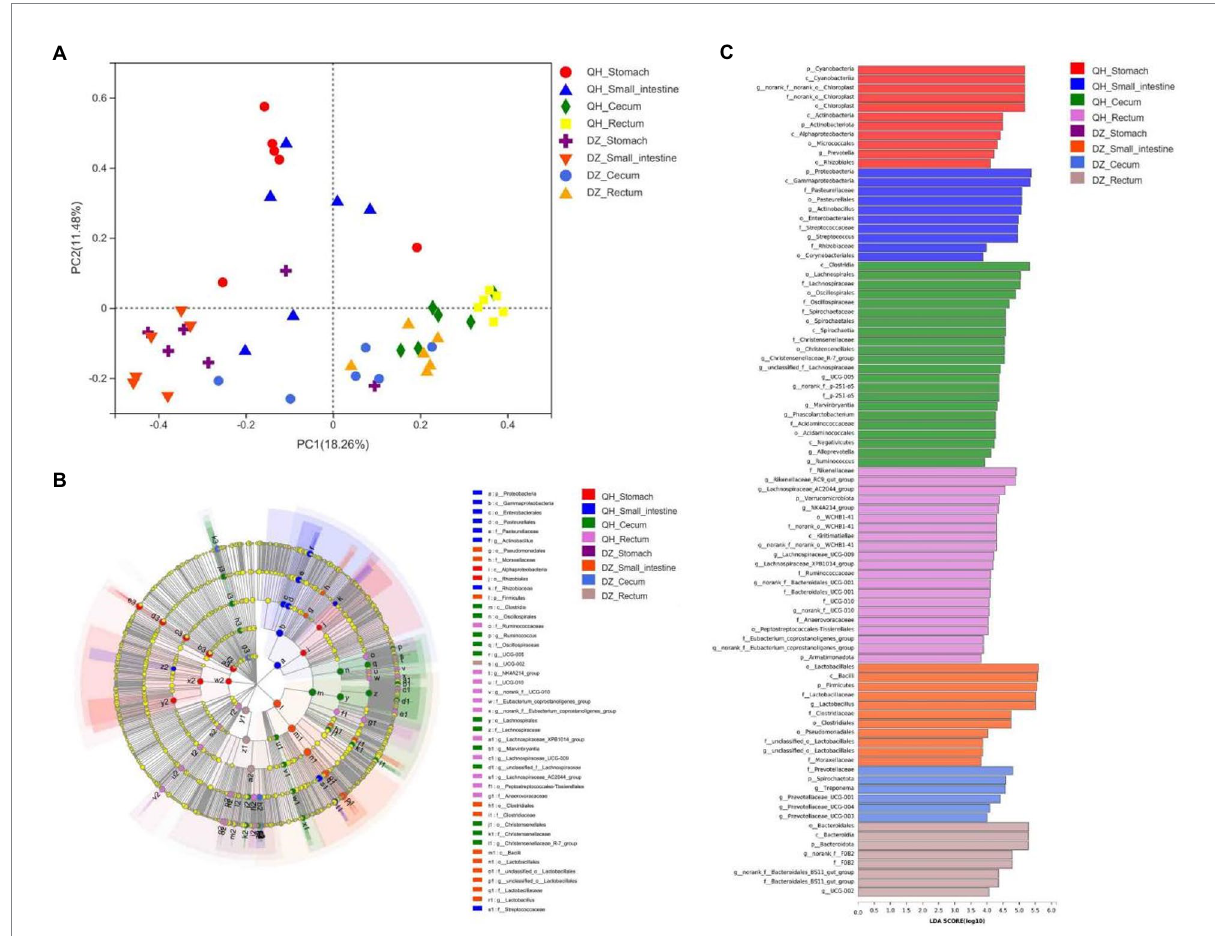
FIGURE 3 Beta diversity analysis. (A) PCoA picture. The X -axis and Y -axis represented the two selected primary axes, and the percentages represented the explanatory value of the differences in sample composition by the primary axes; points with different colors or shapes represented samples in different groups: the closer the two sample points, the more similar the species composition of the two samples. (B) LEfSe diagram. Nodes with different colors indicate microbial groups that were significantly enriched in the corresponding groups and have a significant impact on the differences between groups; light yellow nodes indicate microorganisms that have no significant differences in different groups or have no significant impact on differences between groups. (C) LDA diagram. The abscissa is the LDA score—the greater the LDA score, the greater the influence of species abundance on the differential effect—and different colors represent different